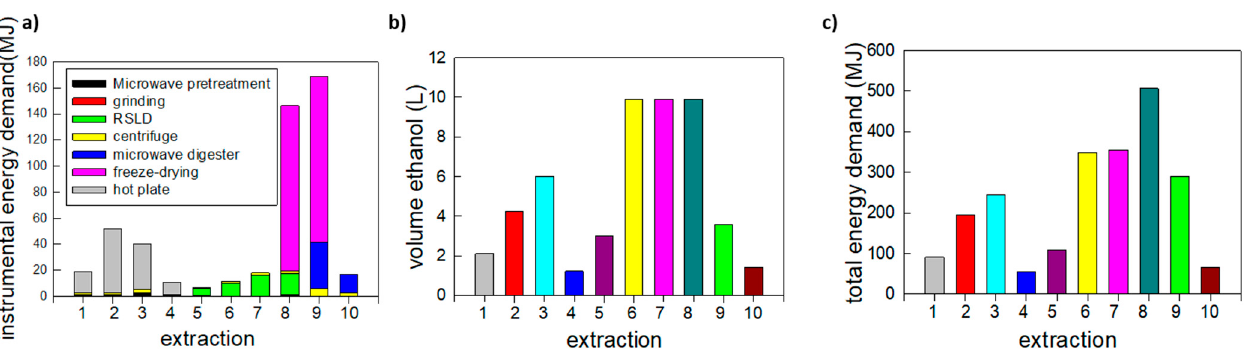
Figure 2. ( a ) Contribution of the different experimental steps to the energy consumed by instruments for producing 10 g of pectin following different extraction protocols; ( b ) volume of ethanol used for the precipitation of 10 g of pectin following different extraction protocols; ( c ) total energy consumed (instruments + chemicals embodied energy) to produce 10 g of pectin following different extraction protocols.